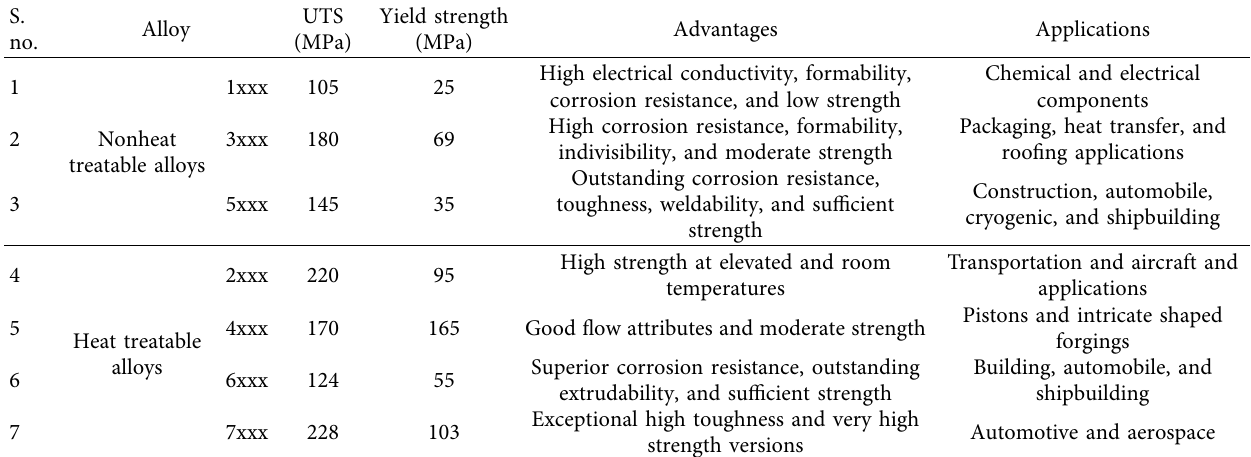
Table 3: Comparison of aluminium alloy properties [9].